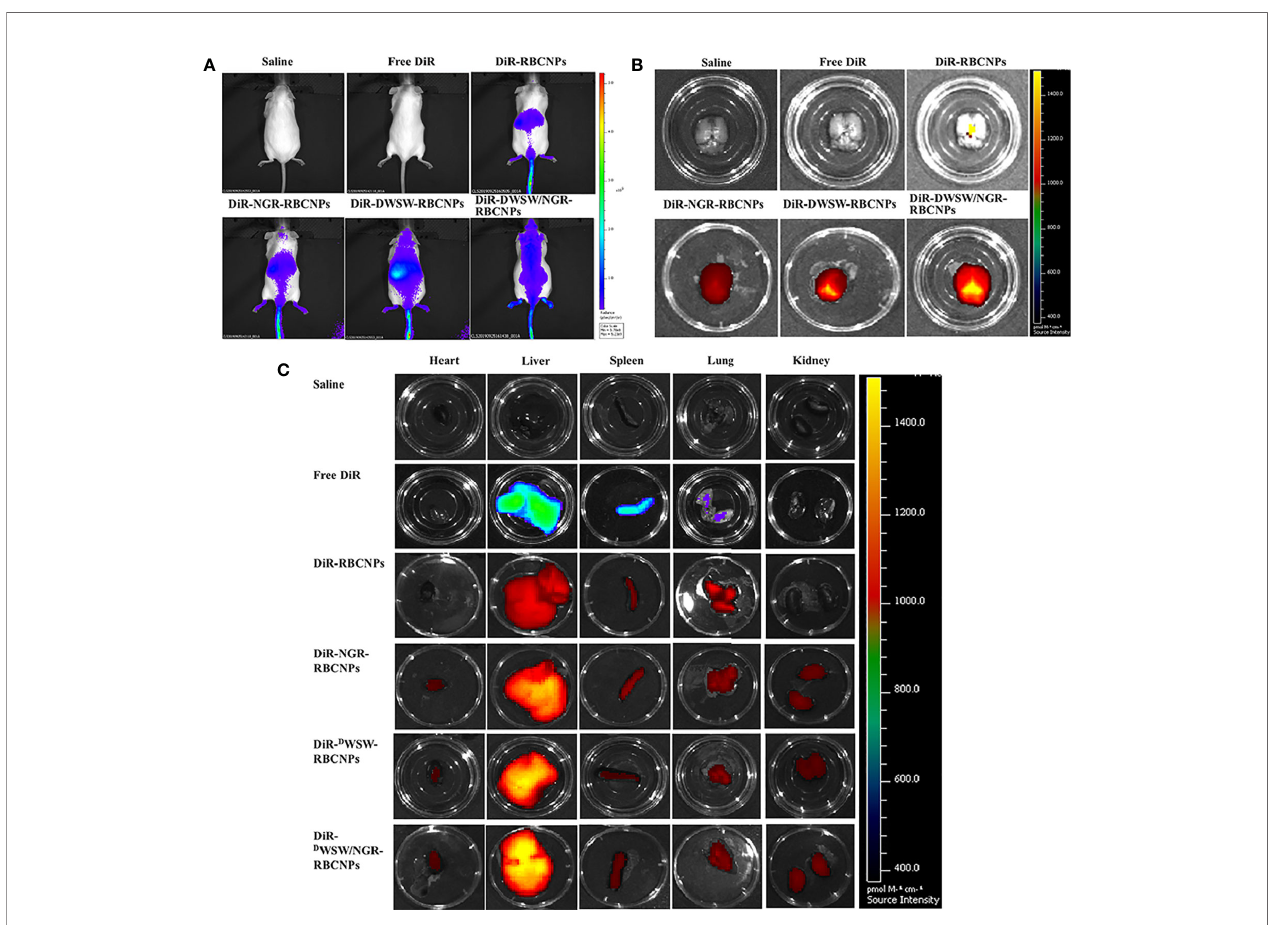
FIGURE 5 | In vivo targeting ability test. In vivo real-time imaging of different DiR-encapsulated nanoparticles in the brain showing the biodistribution of nanocarriers in animals (A) , brain tissue (B) and distribution of different DiR-encapsulated nanoparticles in different organs (C) . The enhancement of targeted modi fi cation leads to increased brain fl uorescence. As the liver plays a predominant role in the elimination of these nanoparticles, it was no surprise that the liver showed the highest levels of accumulation when compared to other organs. These data show that these nanoparticles can target drugs to the brain tissue in an effective